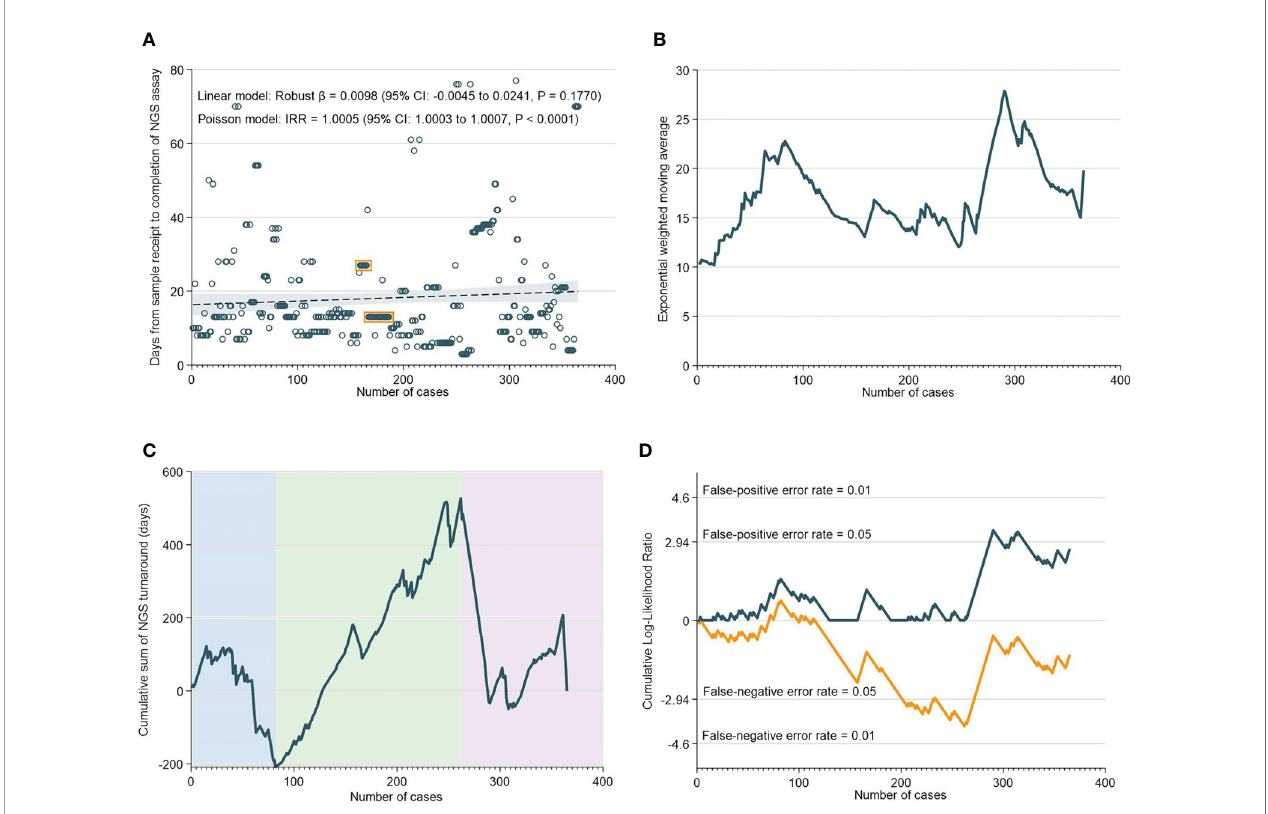
FIGURE 2 | Turnaround Time for NGS Assays. (A) Scatter and regression fi t of NGS turnaround vs case load. (B) Exponential weighted moving average of NGS turnaround time. (C) CUSUM of NGS turnaround time. (D) CUSUM log-likelihood ratio chart for nGS turaround time > 3